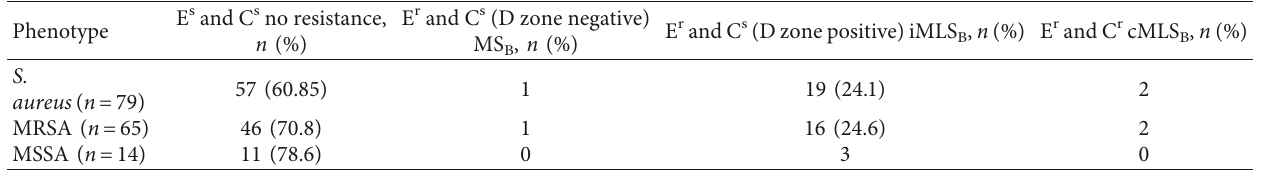
Figure 1: Disk diffusion technique showing D-test inducible clindamycin resistance from wound-infected patients attending Arba Minch Hospital, Arba Minch, South Ethiopia, April to June 2017. Table 5: Susceptibility patterns of isolated S. aureus against erythromycin and clindamycin from wound-infected patients at Arba Minch Hospital, Arba Minch, South Ethiopia, April to June 2017.